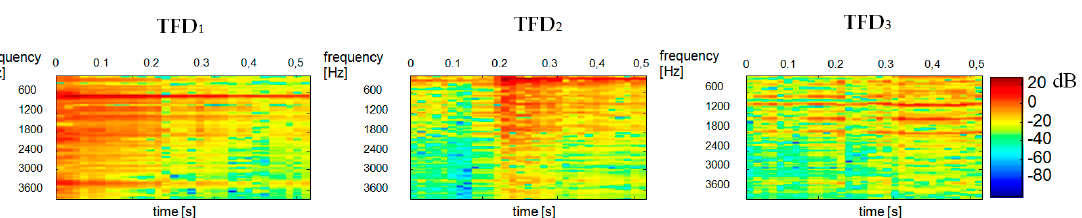
Figure 12. Reconstructed spectrograms of a three-component signal obtained by k-mean partitional clustering and Euclidean distance for 𝑇𝐹𝐷 (cid:3036) bases (duration: 0.51 s): 𝑇𝐹𝐷 (cid:2869) —ringer, 𝑇𝐹𝐷 (cid:2870) —tom, 𝑇𝐹𝐷 (cid:2871) —baby.